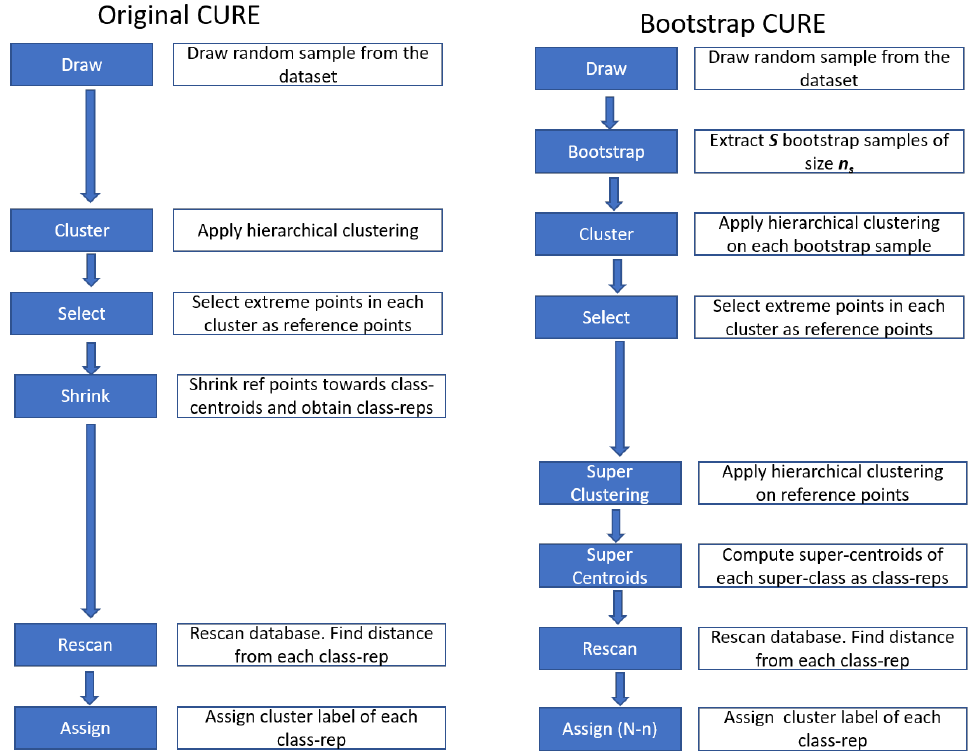
Figure 2. Comparison between original and bootstrap–CURE